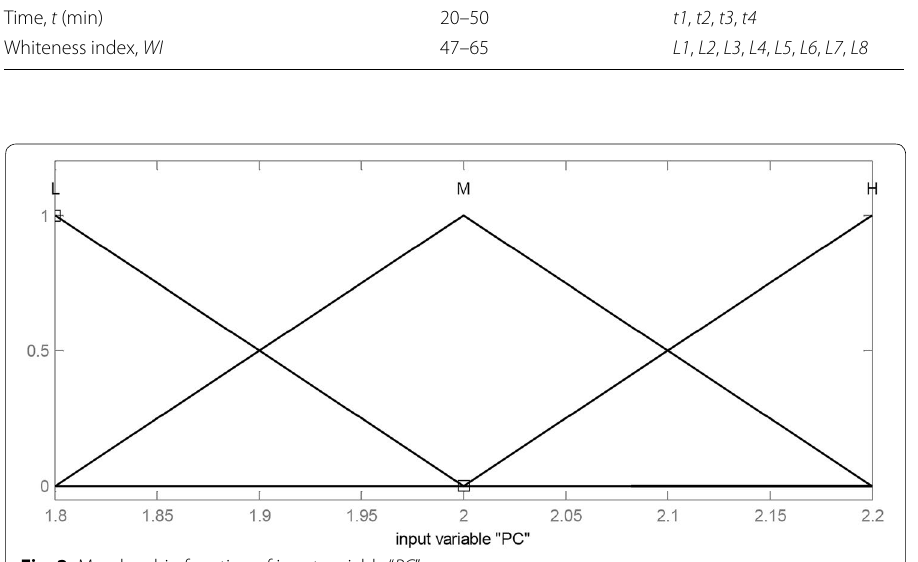
Fig. 2 Membership function of input variable “ PC ”